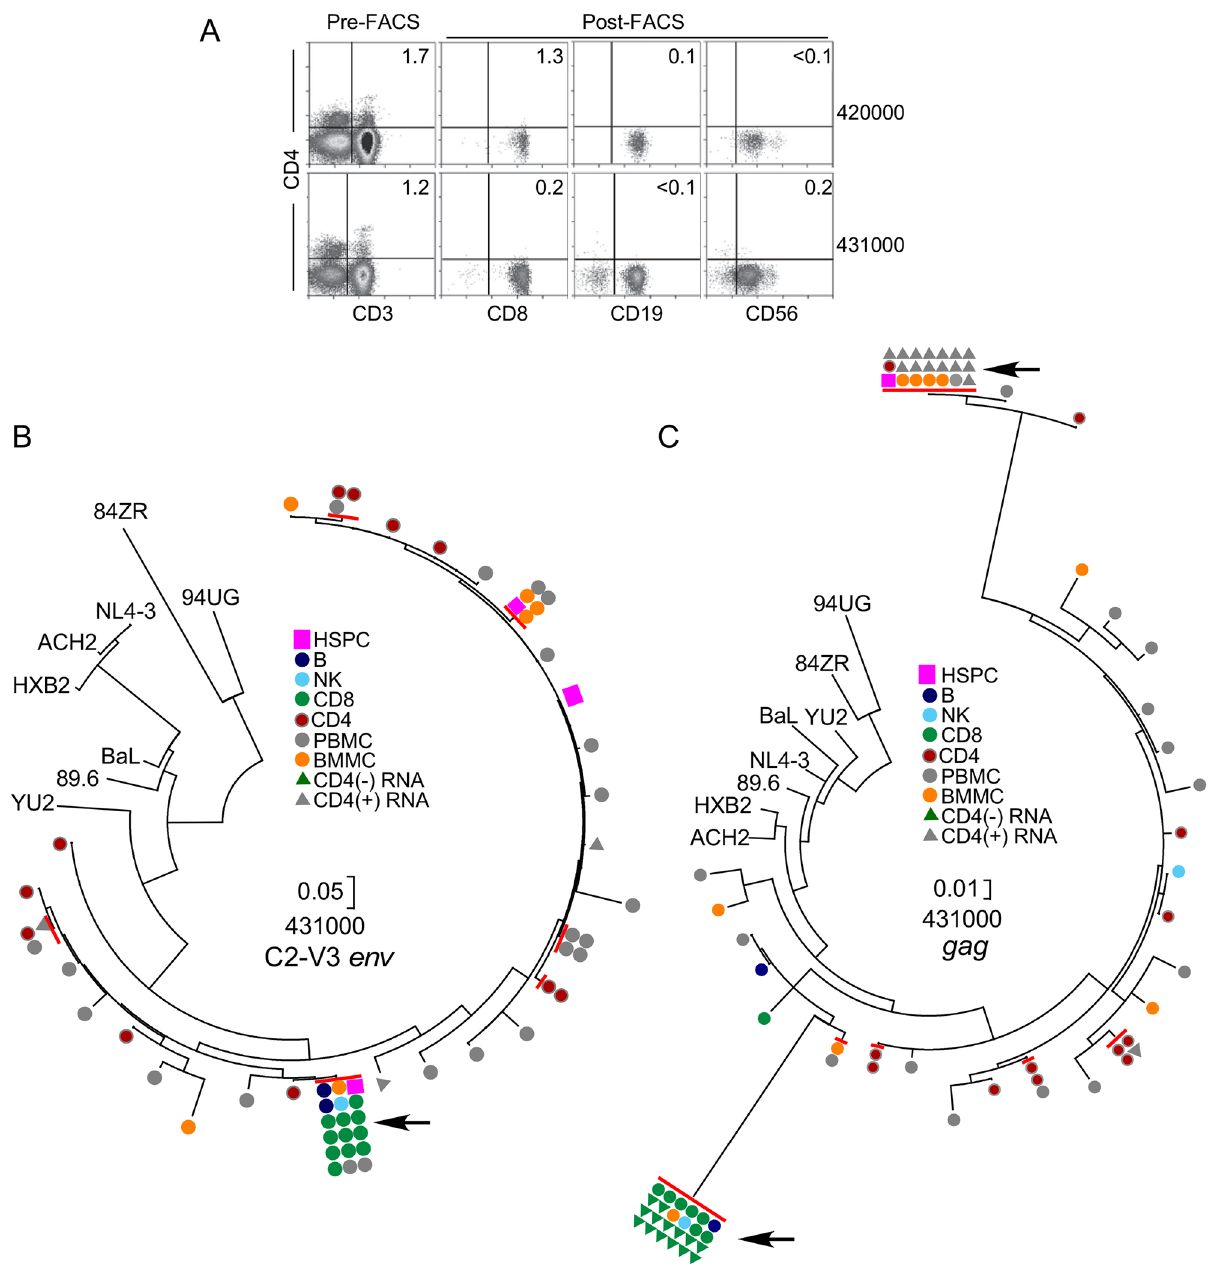
Fig 9. Evidence for transmission of proviral genomes from multipotent CD4 + HSPCs to differentiated peripheral blood cells. A. Flow cytometric plots showingpurity of CD4-negative lineagescontaining provirus identicalto HSPC-derived provirus. “Pre” indicatesthe cell populationpost CD4-beaddepletionand prior to fluorescence activated cell sorting (FACS). “Post” indicates the cell populations followingFACS. Numbersin the upper right corner indicate the frequency of cells in that quadrant. The frequency of CD4 + cells that were also CD3 + by gating was 0% (see also Table 5). B and C. Phylogenetictrees showinggenetic relationships amongst amplicons. HIV RNA shown is cell-associated (Fig 10B). Arrows indicate locationof identicalampliconsshown in Fig 10. Red lines indicateidenticalsequences. Scale indicatesnucleotidesubstitutions per site. ACH2, 89.6, BaL, YU-2, HXB2 and NL4-3 are subtype B HIVs. 84ZR085(84ZR) and 94UG114(94UG) are subtype D HIV molecularclone outgroups[32]. Phylogeneticanalysiswas performed by maximum likelihoodmethod using MEGA7[33]and history was inferred basedon the Hasegawa-Kishino-Yano model [34]. The tree with the highestlog likelihood is shown. Abbreviations: PBMC, unfractionated peripheral blood mononuclear cells; BMMC, bone marrow mononuclear cell (column flow-